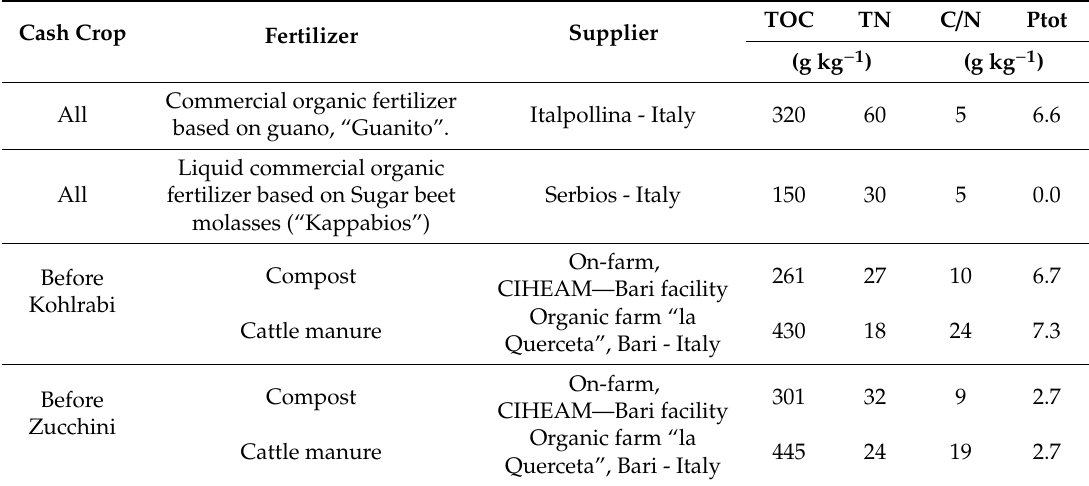
Table 2. Characterization of amendments and fertilizers applied for each crop during the rotation. Cash Crop